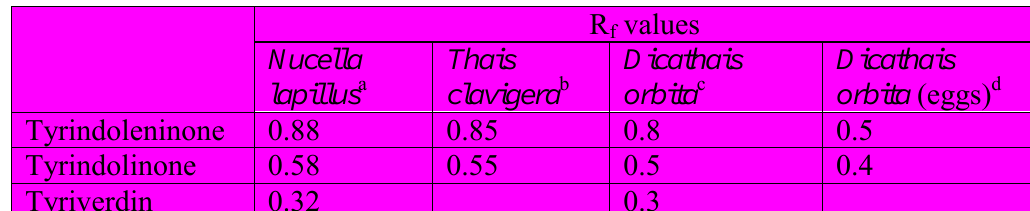
Table 6 . R data for TLC of tyrindoleninone and f